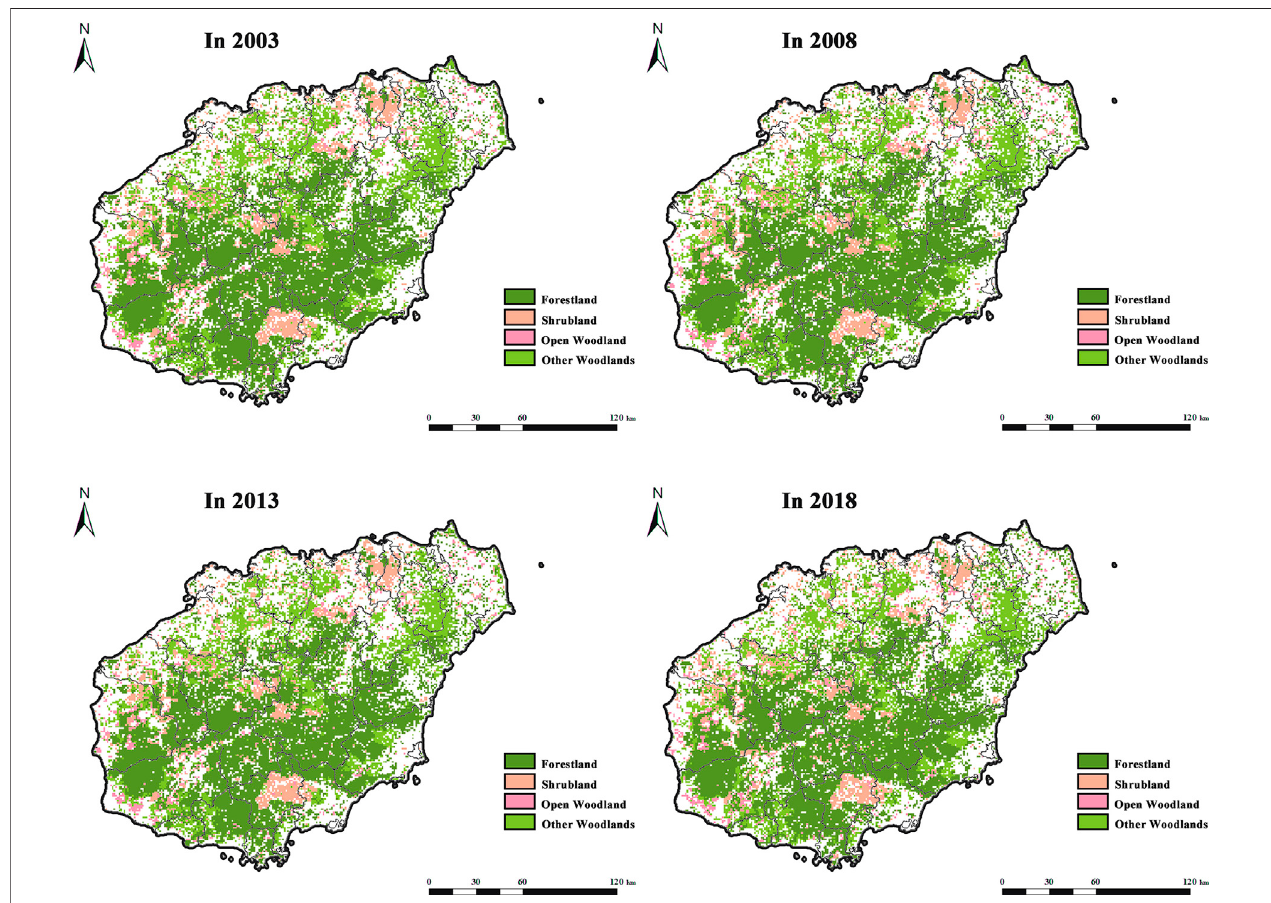
FIGURE 2 | Distribution of forest types in Hainan Island in 2003, 2008, 2013, and 2018 (Forest land refers to natural forests and plantations with a canopy density > 30%, including timber forests, economic forests, shelter forests, and other woodlands. Shrub land refers to the low woodland and shrub woodland with a canopy density > 40% and height below 2 m. Open woodland refers to the woodland with a canopy density of 10 – 30%. Other woodlands refer to unforested woodlands, slashes, nurseries, and all kinds of gardens, such as orchards, mulberry gardens, tea gardens, and hot forest gardens).